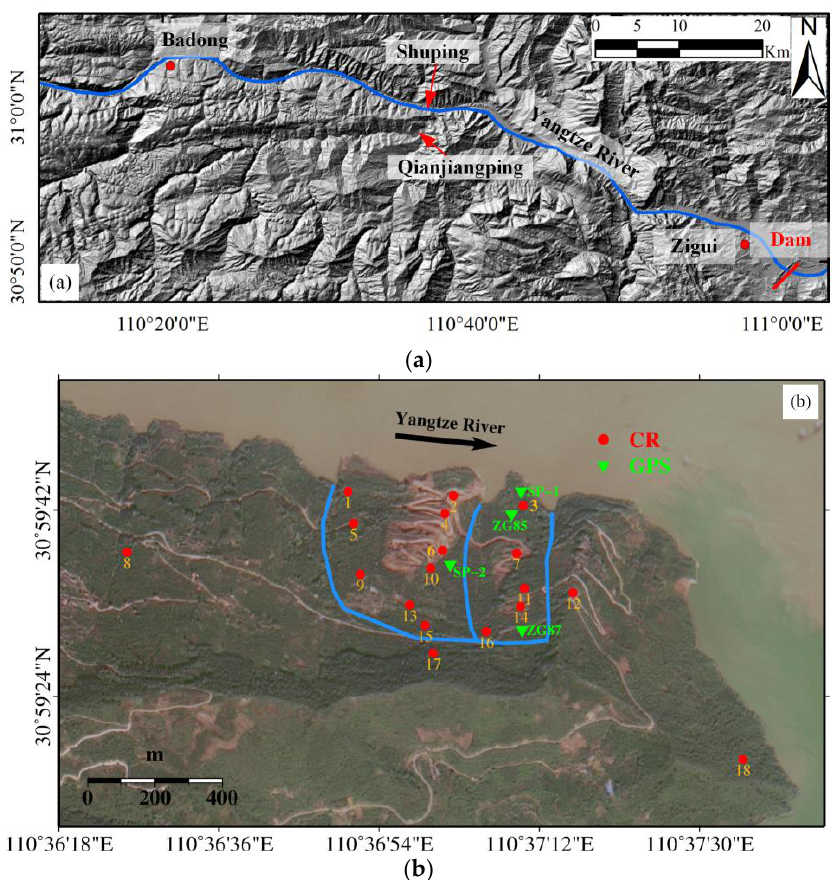
Figure 1. ( a ) Location of the Shuping landslide; ( b ) Location of corner reflectors and GPS stations installed on the Shuping landslide overlaid on ZY-3 satellite multispectral optical image.